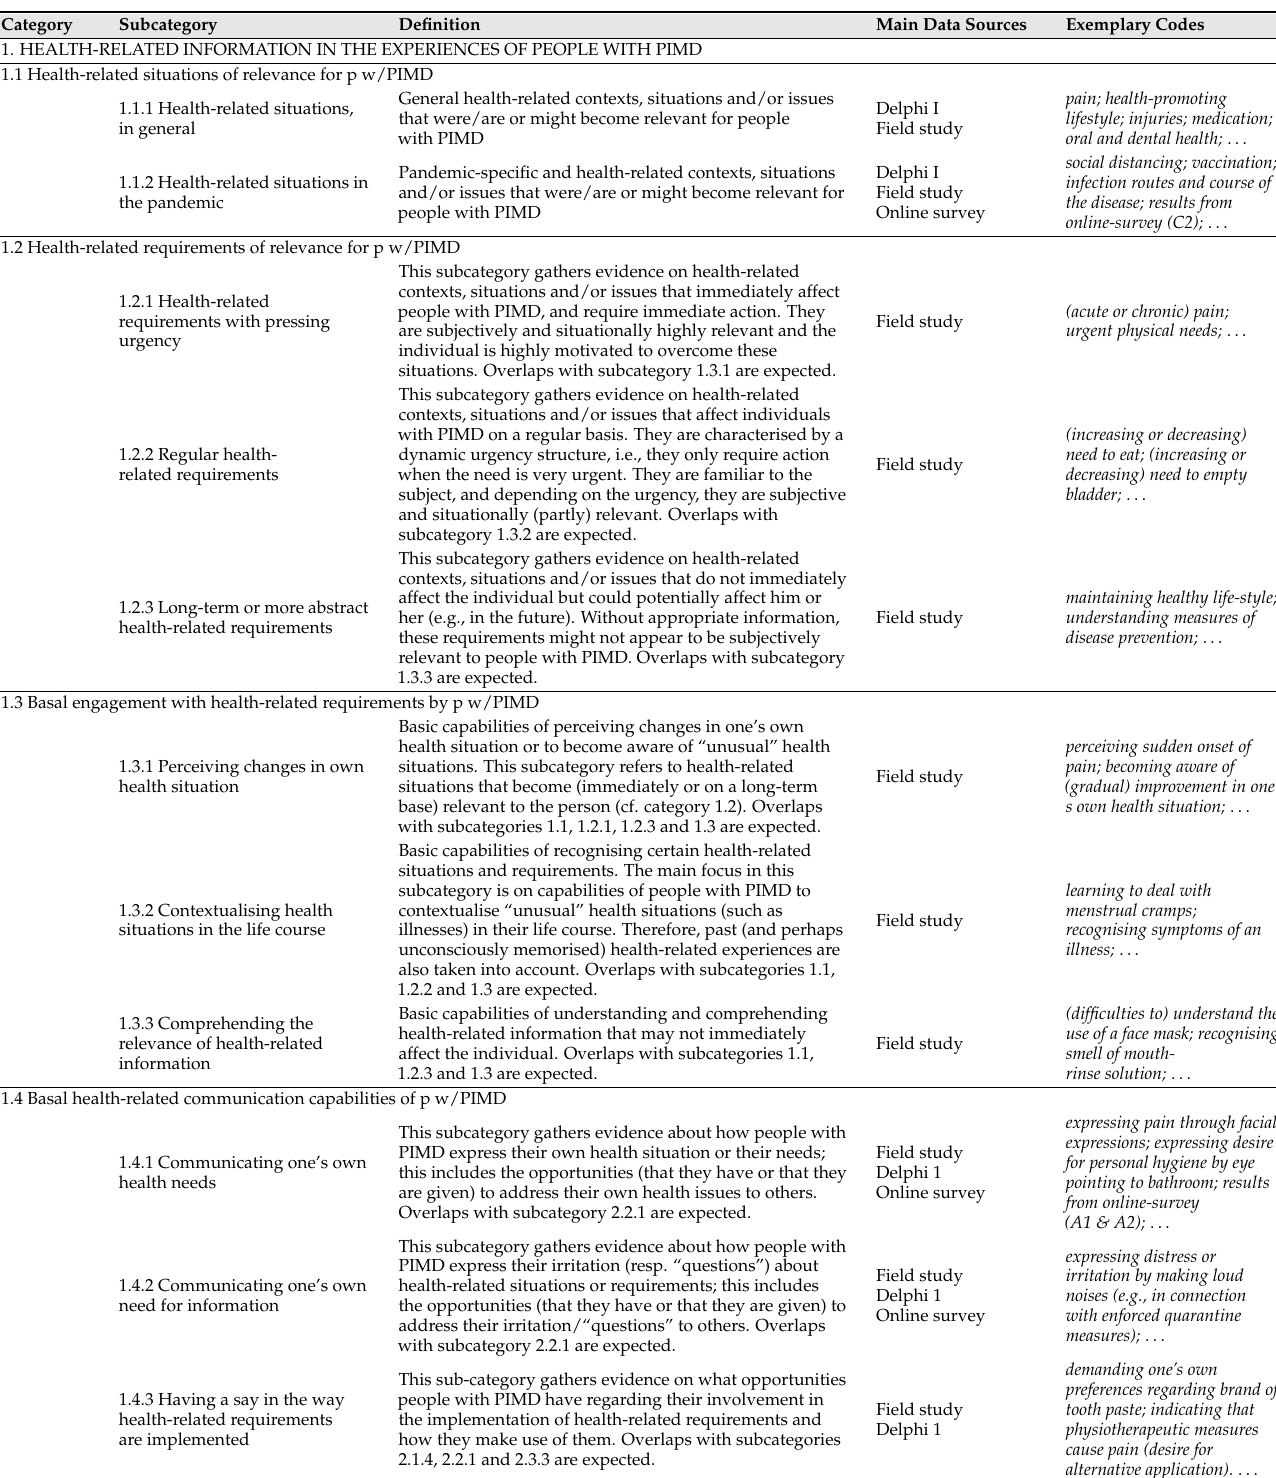
Table A3. Excerpt from codebook for overall analysis (focus on the categories & subcategories